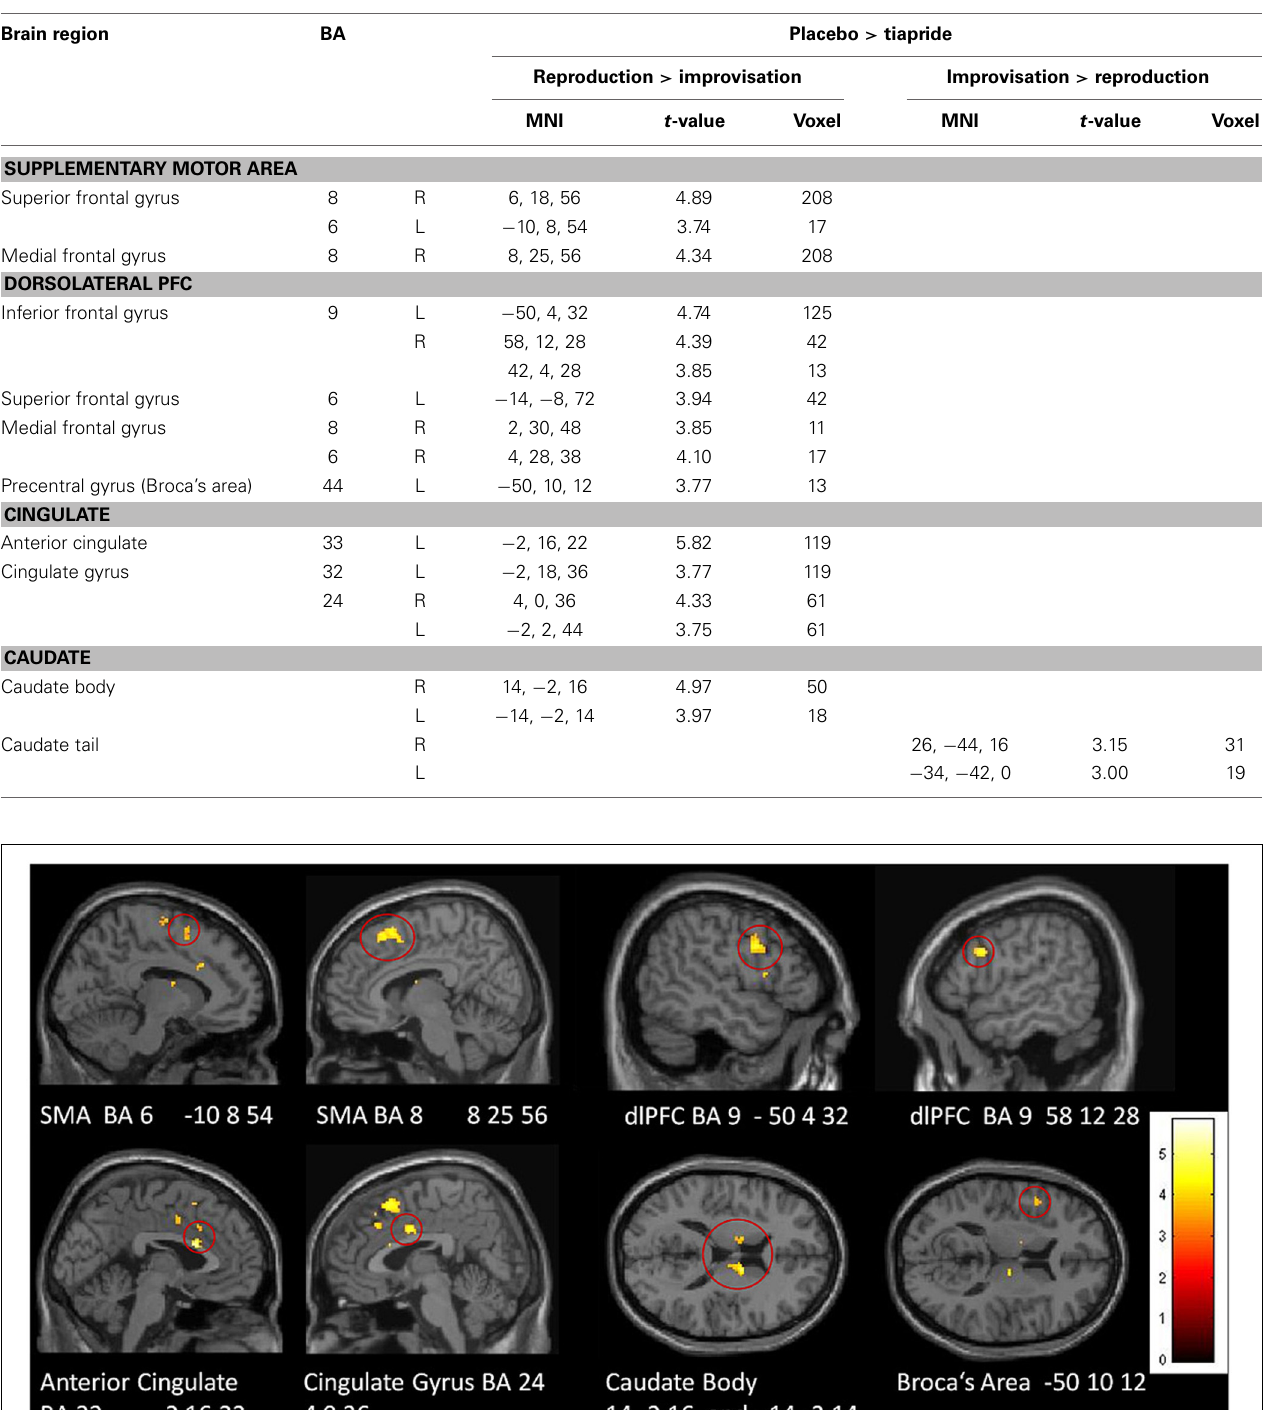
Table 5 | Reduced activation in the tiapride group compared to the placebo group (two-sample t -tests, contrast placebo > tiapride in improvisation > reproduction and reproduction > improvisation, p < 0 . 001, k = 10).